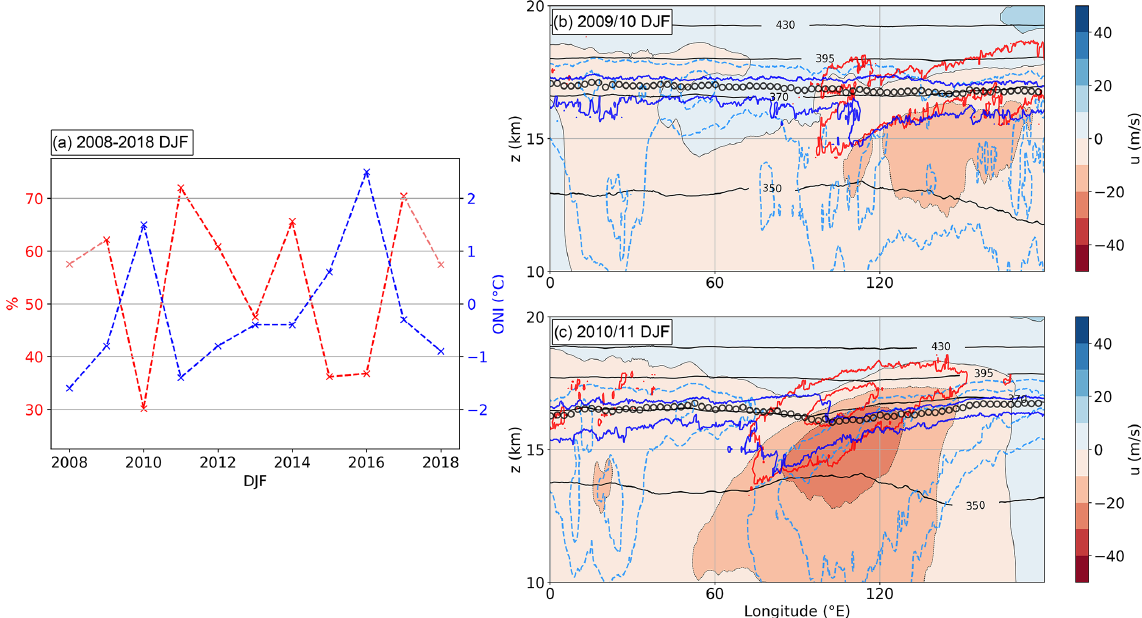
Figure 13. (a) Comparison of the Oceanic Niño Index sea surface temperature anomaly for DJF (ONI, blue graph) with the strong shear occurrence frequency during DJF averaged over the region from 100 to 130 ◦ E and from the Equator to 10 ◦ N (red graph). The values for January–February 2008 and December 2017 are included (light red). ONI values from https://www.noaa.gov/ (last access: 16 July 2021). (b, c) Temporal mean of a zonal cross section at the Equator, averaged in geometric height coordinates, for the two consecutive DJF seasons 2009/10 and 2010/11. Color contour shows mean zonal wind component ( u , in ms − 1 ). Solid red lines show the 10% and the 50% isolines of occurrence frequencies for S 2 ≥ S 2 t . Solid blue lines show the 10% and the 50% isolines of occurrence frequencies for N 2 ≥ 4 × 10 − 4 s − 2 . Black circle markers indicate LRT altitude, and solid black lines show isolines of potential temperature ( (cid:50) , in K). Dashed light blue lines indicate the isolines of 70% and 85% relative humidity over